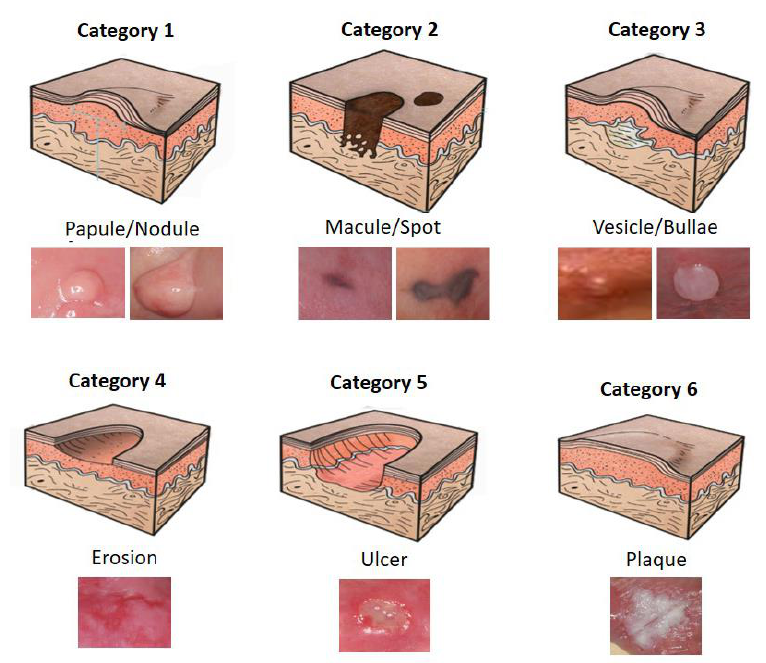
Figure 2. Schematic representation of elementary lesion categories.